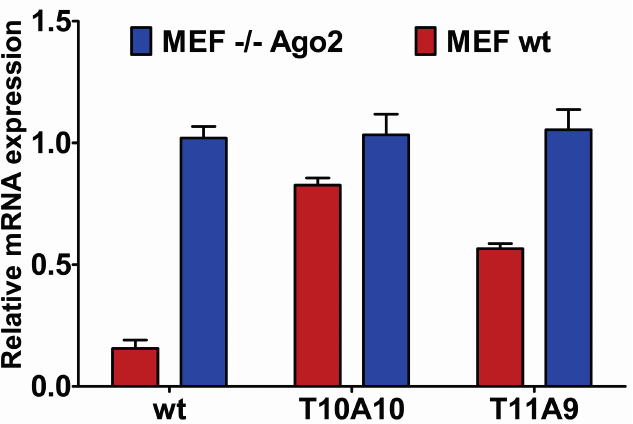
Figure 5. Renilla mRNA reduction in MEF wt and MEF Ago2 − / − cells. 1 nM of unmodified ( wt ) and modified ( T10A10 and T11A9 ) siRNAs were co-transfected with